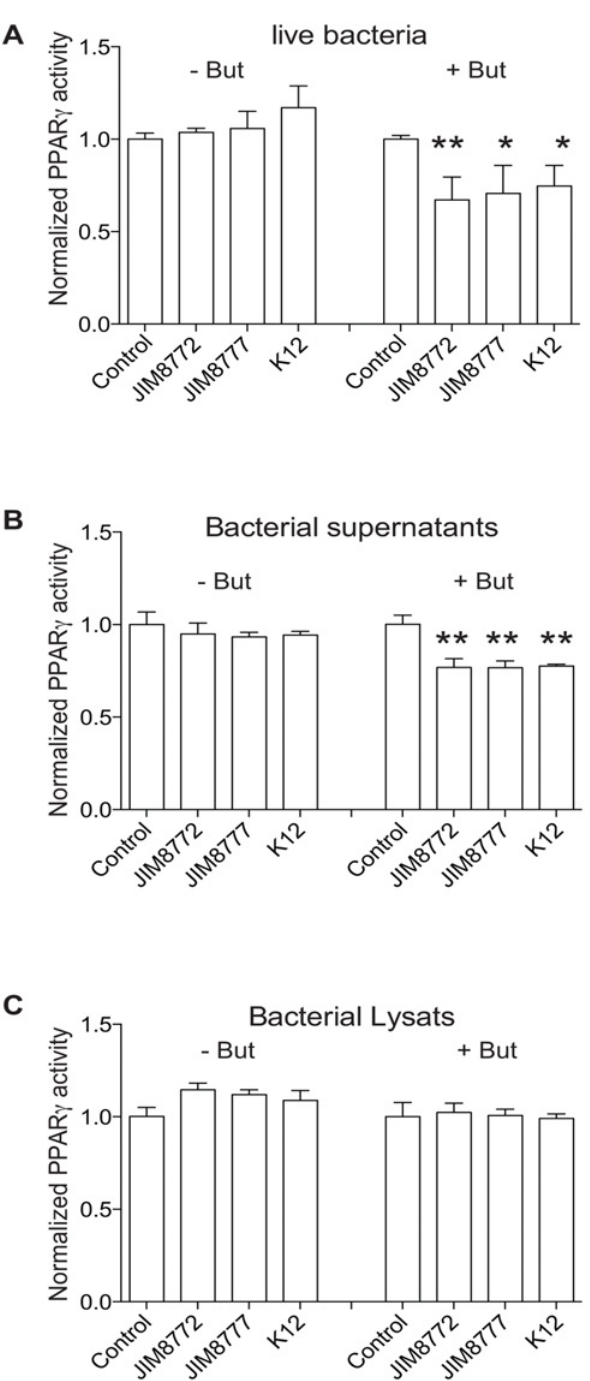
Fig 2. The S . salivarius – dependent down-regulation of PPAR γ activity relies on secreted molecules. PPAR γ was activated (+ But) or not (- But) in HT-29 reporter cells using sodium butyrate (2mM) in the presence of control medium (Control) or as indicated live bacteria (A), bacterial supernatants (B) or lysates (C). The values represent the luciferase activity normalized towards their respective control. Data are expressed as means ± standard deviations (SD) of triplicate measurements from one representative experiment out of three independent experiments. *** P < 0.001, ** P < 0.005, compared with controls (Student's